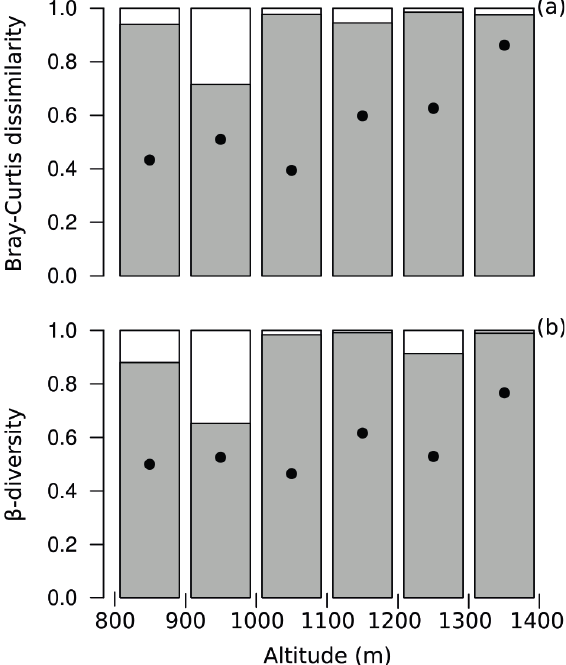
Figure 3. Results from the partitioning of butterfl y community variation comparing consecutive altitudes in increasing order. In the Bray-Curtis dissimilarity (a), gray bars represent the proportion of balanced variation in abundance (replacement of individuals of some species by individuals of other species), while white bars indicate the proportion of abundance gradient (equal loss of individuals among all species; Baselga 2017). For β-diversity (b), gray bars represent the species turnover component of the community shifts, while the white bars indicate the nestedness- resultant component in each altitude comparison. Black dots represent overall values of (a) Bray-Curtis dissimilarity and (b)